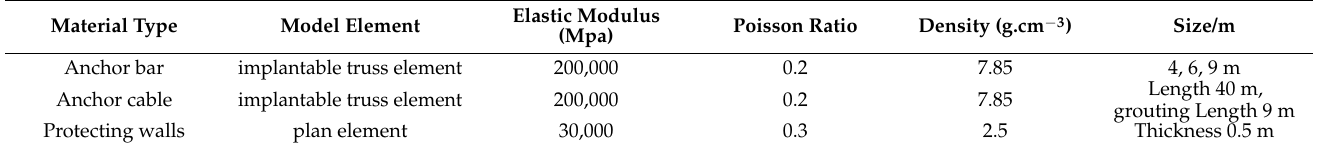
Table 2. The design parameters of the supporting structure.